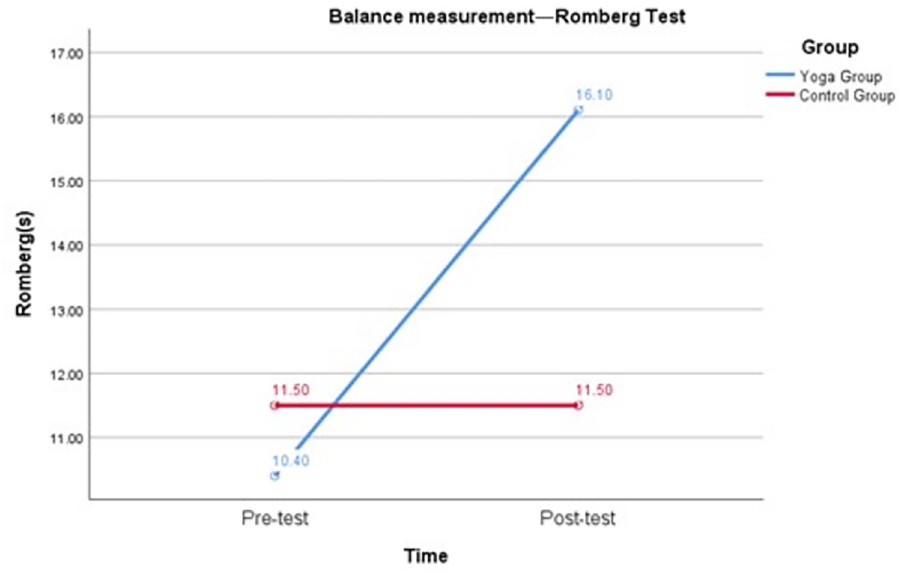
Fig 3. Balance measurement—Romberg test.